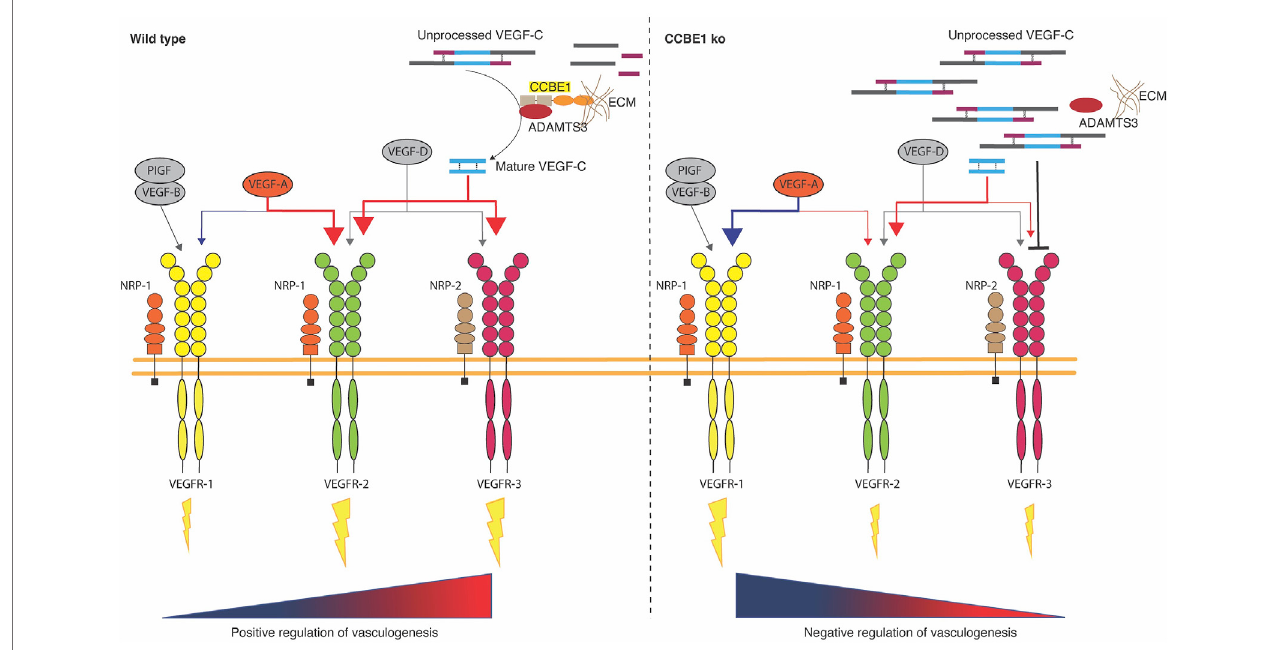
FIGURE 3 | The VEGF family and receptor activation in the presence and absence ofCCBE1. Left panel: CCBE1-ADAMTS3 complex promotes the processing of the mature form of VEGF-C, which positively regulates vasculogenesis via VEGFR-2 and -3 activation. Right panel: absence of CCBE1 leads to an accumulation of the unprocessed form of VEGF-C. Unprocessed VEGF-C binding to VEGFR-3 does not increase VEGFR-3 signaling but displaces mature VEGF-C from VEGFR-3. Displaced mature form of VEGF-C competes with VEGF-A for binding to VEGFR-2 and enhancing the binding-af fi nity of VEGFR-1 for VEGF-A, which translates in negatively regulation of